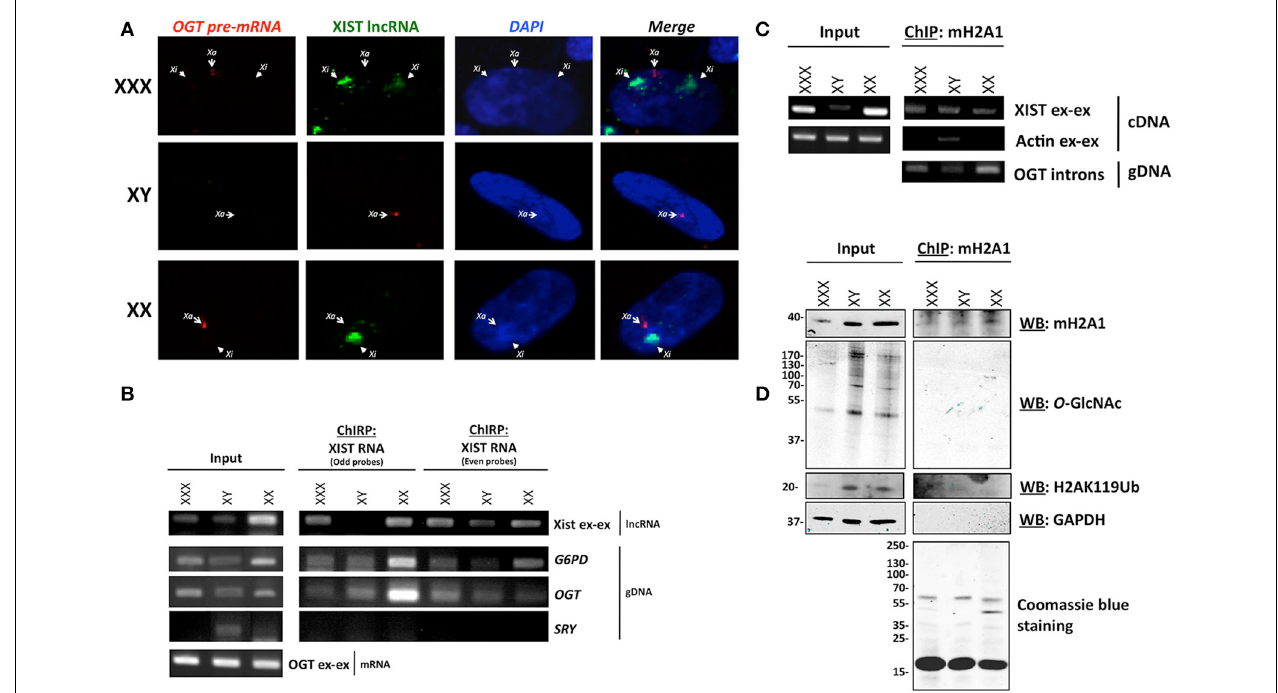
FIGURE 2 | OGT is expressed from Xa and extra- OGT alleles are part of the X-inactivation complex. (A) RNA-FISH analysis of the OGT primary transcript and XIST lncRNA in male, female and triple-X female cells indicates that OGT expression does not co-localize with the Xist lncRNA. Xa: active X-chromosome; Xi: inactive X-chromosome. (B) Chromatin isolation by RNA Purification (ChIRP) of XIST RNA, a major component of Barr body, shows interaction of the OGT locus with XIST